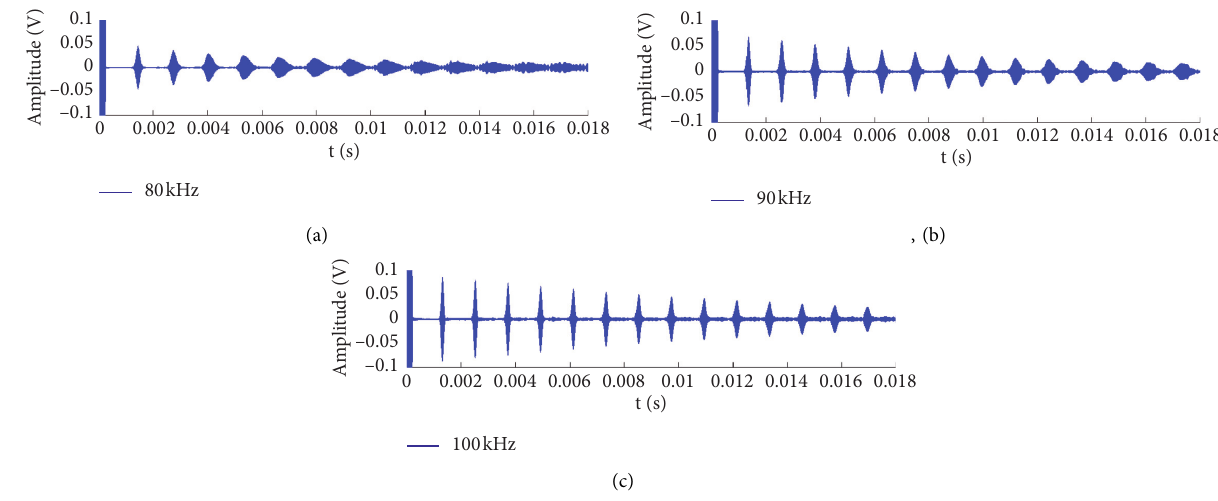
Figure 17: Multiple reflection from the right end of a normal hexagonal pipe, at the center excitation frequency of (a) 80 kHz, (b) 90kHz, and (c) 100kHz using the PZT ring with the size of 25mm × 5mm × 0.5 mm.